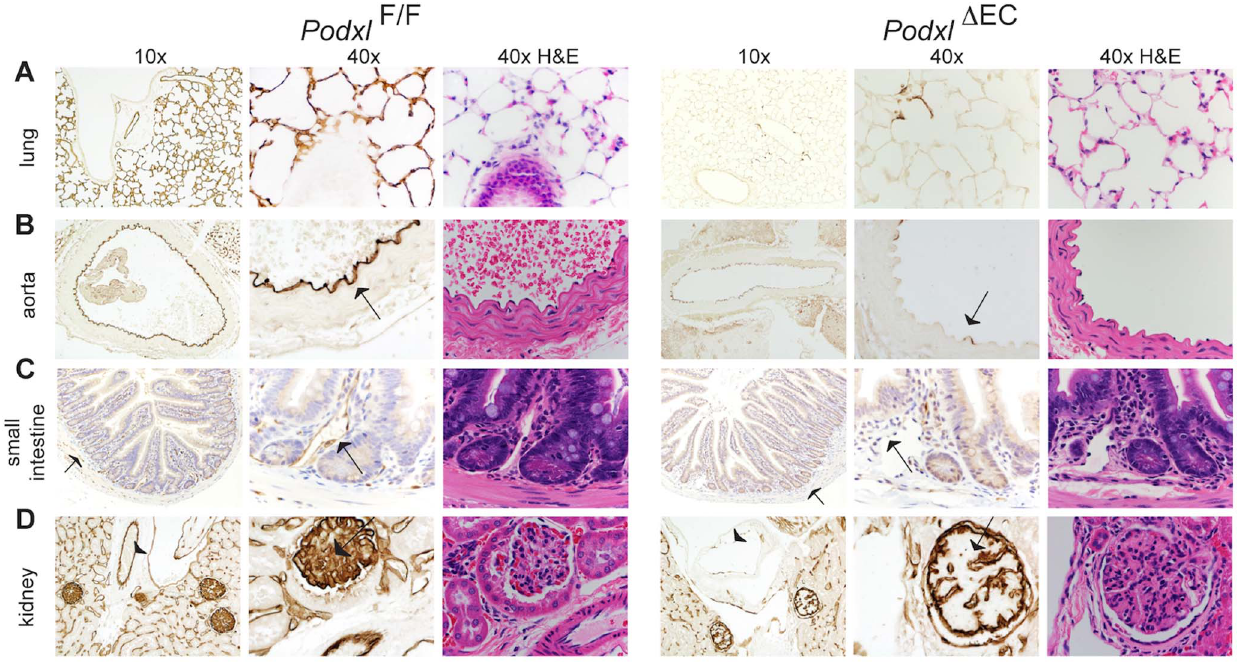
Figure 2. Cdh5 -Cre drives efficient deletion of podocalyxin in the lung. ( A ) Podocalyxin expression is completely abrogated in the lung of Podxl D EC mice. ( B , C ) Within the aorta and vessels of the small intestine (arrows), podocalyxin is deleted in all but a few isolated cells in Podxl D EC mice. ( D ) Within the kidney, podocalyxin (brown staining) is efficiently deleted in the glomerular endothelial cells (arrows, 40x mag. panels) and larger vessels (arrowheads, 10x mag. panels). Positive staining in the glomerulus of Podxl D EC kidney are likely podocyte epithelial cells. Adjacent H&E sections included demonstrating normal morphology with loss of podocalyxin expression in these tissues.